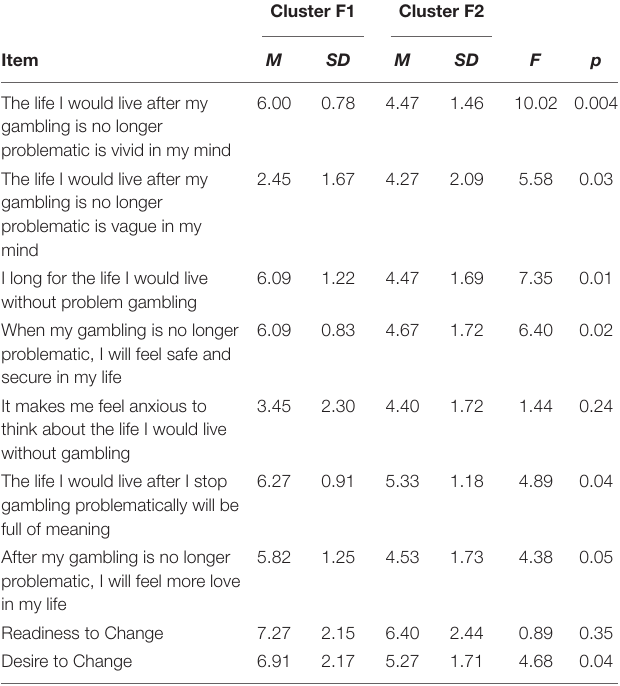
TABLE 5 | Future perception ratings and behavior change measures between future